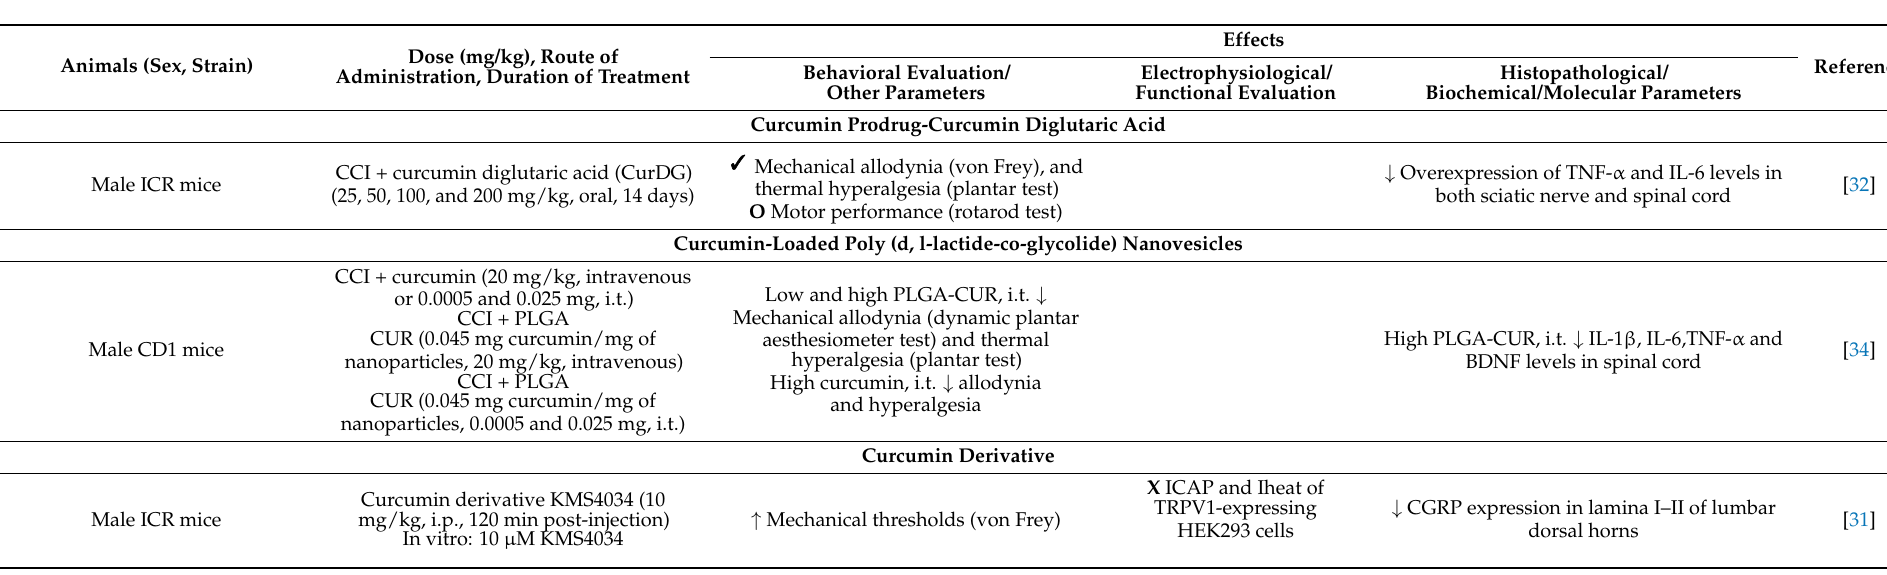
Table 2. Effects of curcumin on alcoholic neuropathy, chemotherapy-induced peripheral neuropathy (CIPN), and diabetic painful neuropathy